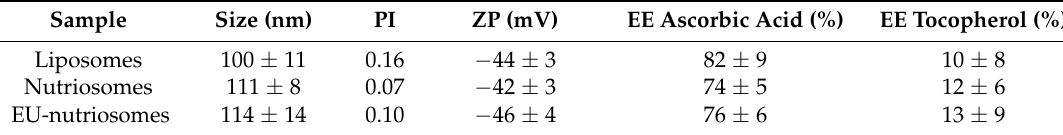
Table 1. Average size, polydispersity index (PI), zeta potential (ZP) and entrapment efficiency (EE) of liposomes, nutriosomes and EU-nutriosomes.